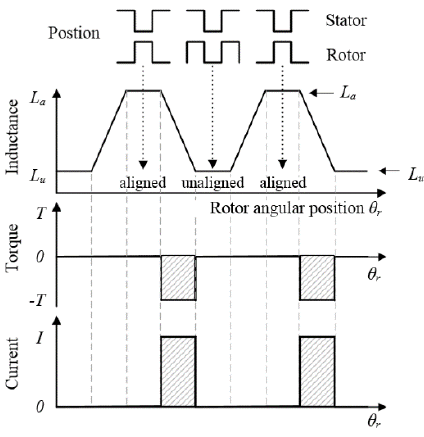
Figure 3. Torque relationship between the idealized inductance profile and the phase